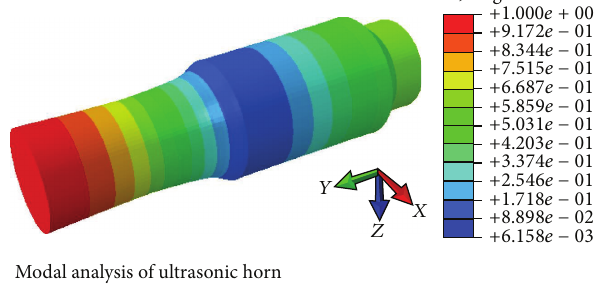
Figure 4: Modal analysis chart of ultrasonic